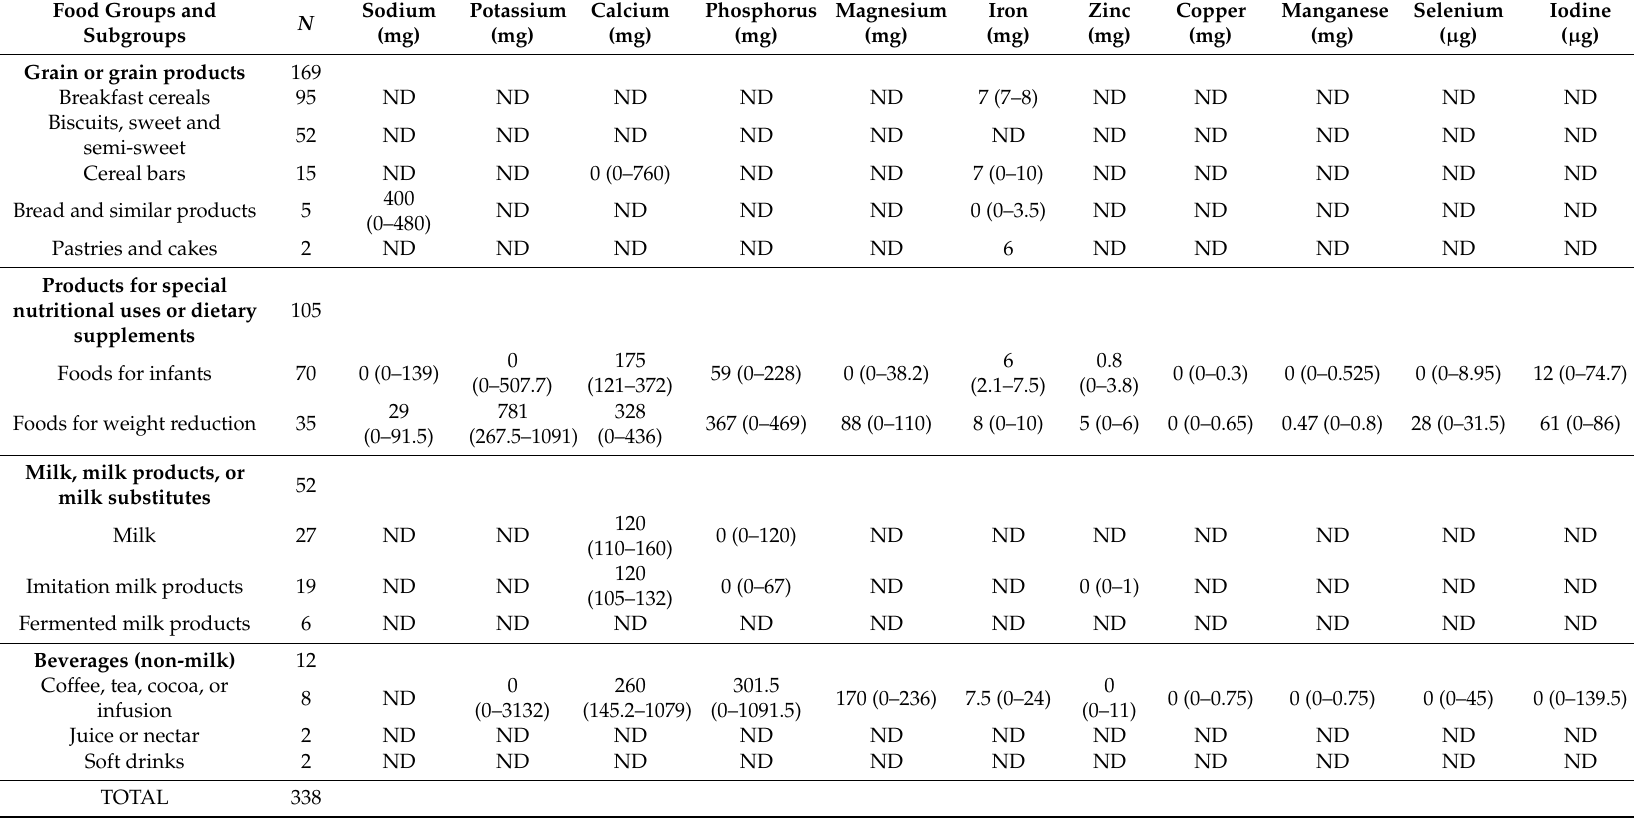
Table 3. Mineral content distribution in folic acid-fortified food products from the Spanish